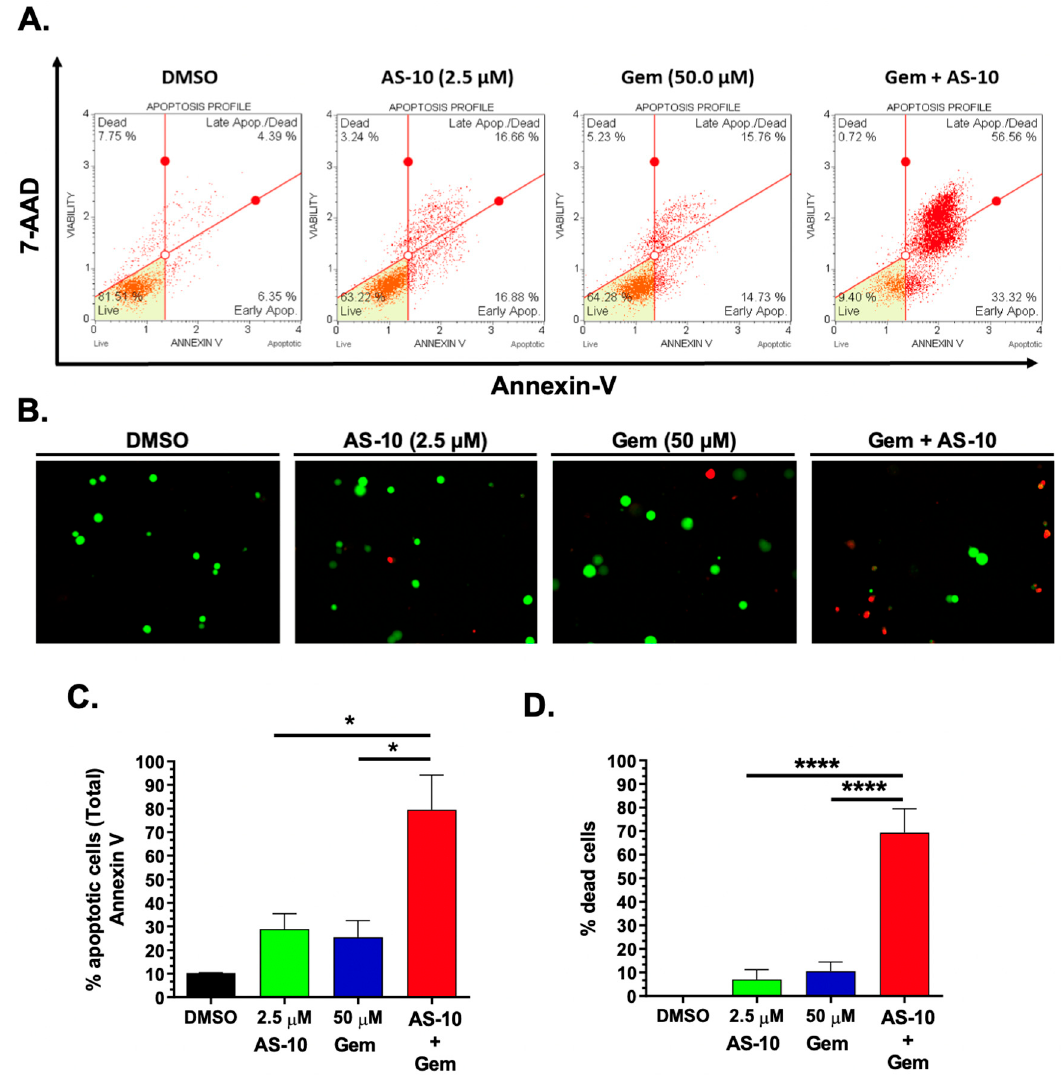
Figure 8. AS-10 potentiated the cytotoxic effects of gemcitabine on Panc-1 cells. Panc-1 cells were treated with AS-10 and/or gemcitabine (Gem) for 48 h and were analyzed by: ( A , C ) Muse Live/dead Annexin V assay: Histograms show four quadrants: bottom-left quadrant (Healthy cells (7-ADD (-), Annexin V (-))); bottom-right quadrant (Early apoptotic (7-ADD (-), Annexin V (+))); top-right quadrant (Late apoptotic/dead cells (7-ADD (+), Annexin V (+))); top-left quadrant (necrotic (7-ADD (+), Annexin V (-))); ( B , D ) Live/dead calcein-AM and ethidium bromide staining: Microscopic fluorescence images of calcein-AM-stained live cells (green color) and ethidium bromide-stained dead cells (red color); ( C , D ) Quantification of total apoptotic cells and total dead cells obtained from ( A , B ), respectively. Data represents mean ± SD * ( p < 0.05); **** ( p <